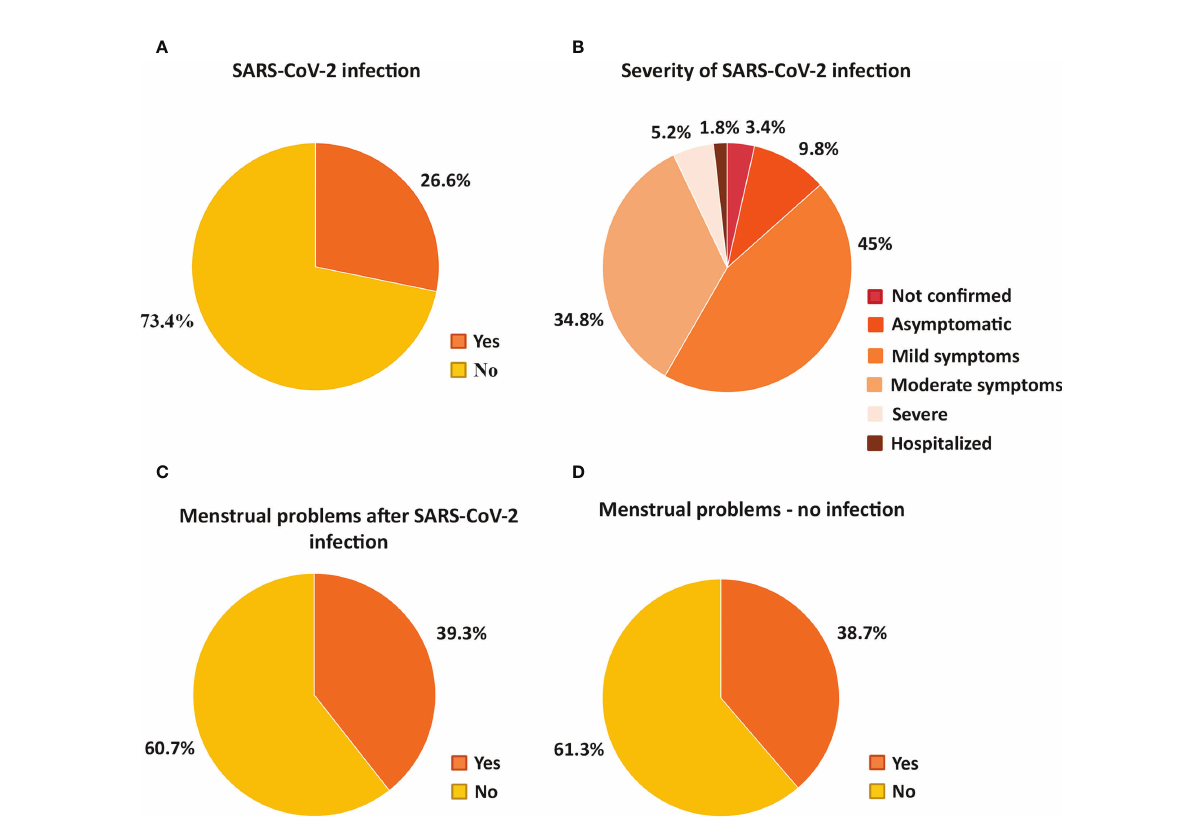
FIGURE 3 Pie charts show the percentage of participants who were or were not infected with SARS-CoV-2 (A) , detailing the proportion of infected individuals based on the severity of the infection (B) . The percentage of participants with and without menstrual cycle problems after SARS- CoV-2 infection (C) or no infection (D) is also